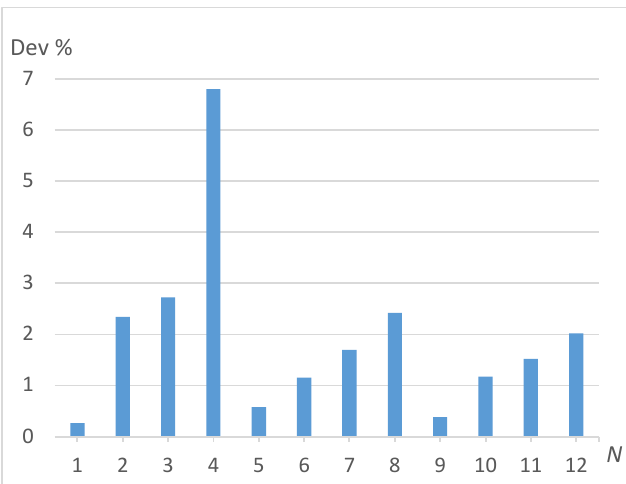
Fig. 13. The difference in power consumption when the optimisation algorithm is